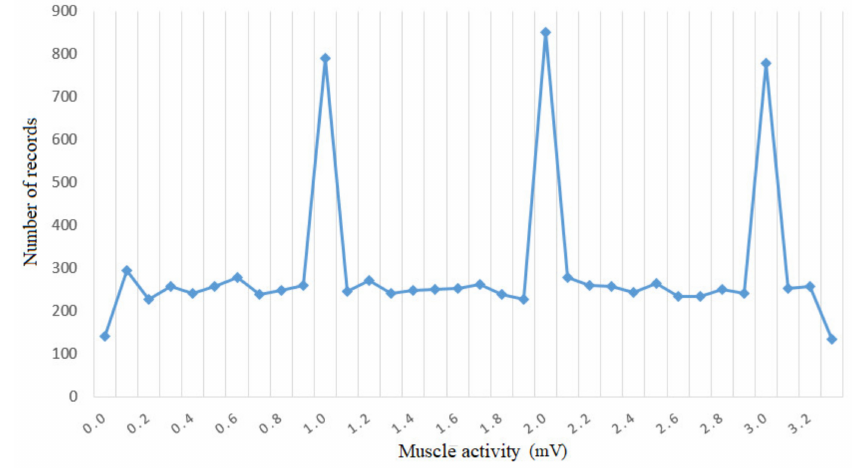
Figure 9. Histogram for muscle